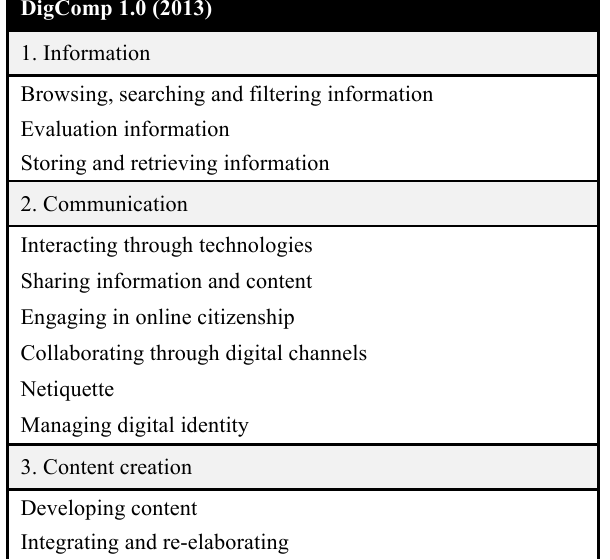
Table 1. Digital competence frameworks 1.0